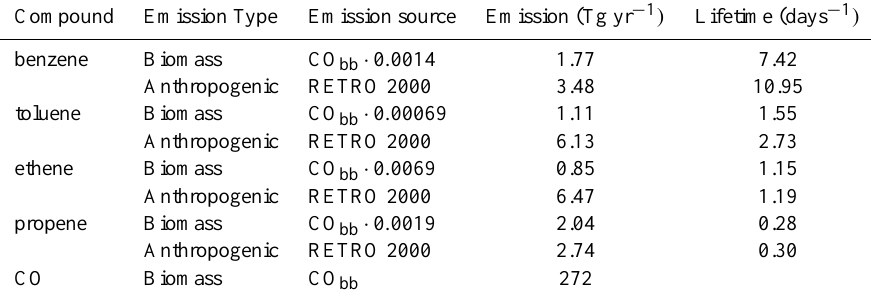
Table 2. Emissions and derived lifetimes of the simulated